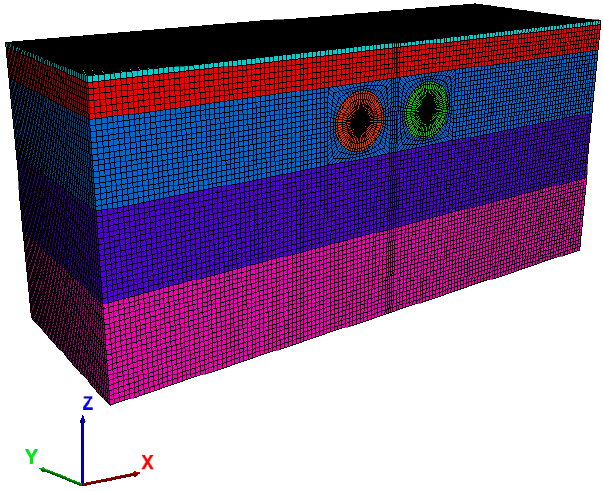
Figure 9. Three-dimensional numerical calculation model.